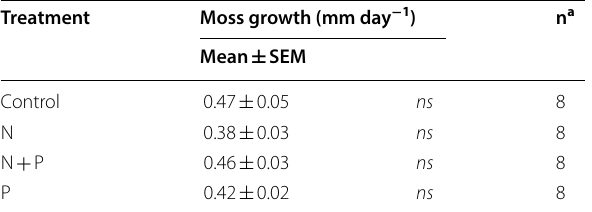
Table 2 Sphagnum moss growth (mm day − 1 ) for each treatment